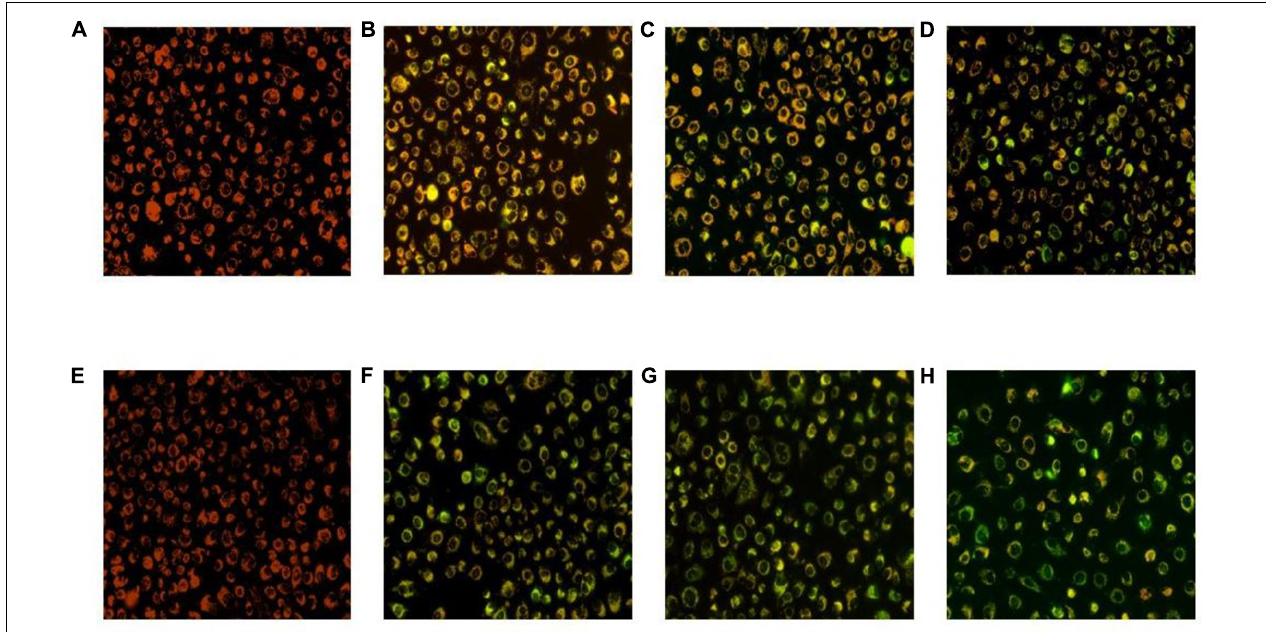
FIGURE 5 | Mitochondrial membrane potential of the HT-29 cells treated with L. acidophilus KLDS1.0901. L. acidophilus KLDS1.0901 treated with HT-29 cells of different MOI (10, 50, and 100) for 24 h (A–D) and 48 h (E–H) . A fluorescence microscope was used to photograph images (20 × ).